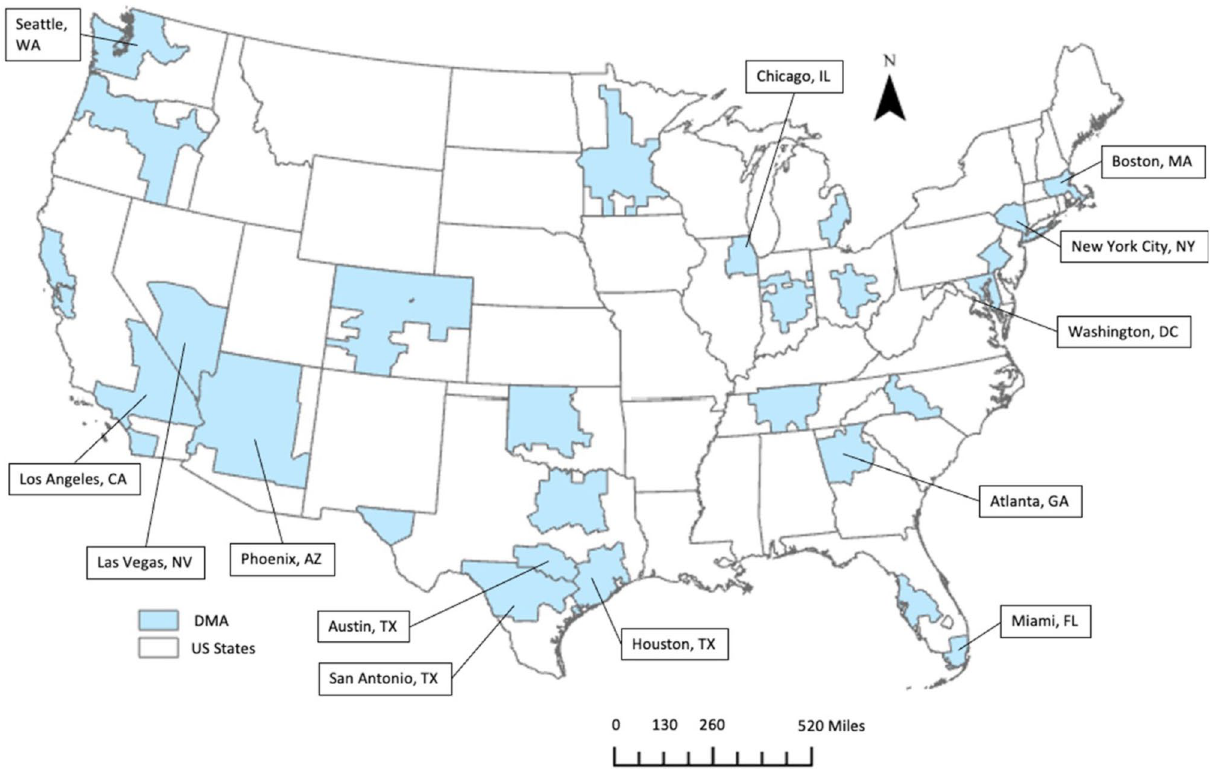
Figure 2. Location of the 30 Nielsen Designated Marketing Areas (DMA) defined by one or more US counties for which Google Trends and ED data was available. County and state shapefiles provided by the United States Census Bureau TIGER/Line shapefiles. Map created using ArcGIS Pro version 2.8